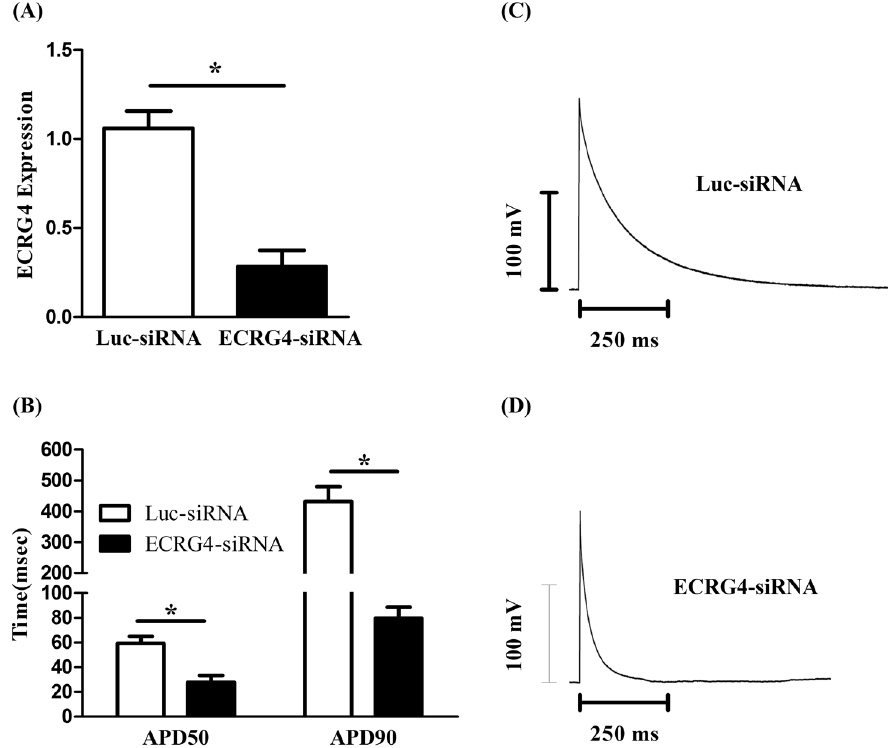
Figure 6. Knockdown ECRG4 in neonatal atrial myocytes shortens APD. Neonatal atrial CMs were transduced with lentivirus expressing Ecrg4-siRNA or luciferase-siRNA for 36 hours and the knock down of ECRG4 was confirmed by real-time PCR showing a 74% decreased ECRG4 expression in Ecrg4-siRNA (black bar) relative to Luc-siRNA transduction (open bar) ( A , P < 0.05). Thirty-six hours after transduction, AP was recorded using patch-clamp on GFP positive CMs. Representative recordings showing APs in Luc-siRNA ( C ) and Ecrg4-siRNA ( D ) transduced CMs. Quantitative analysis of APD 50 ( B , left panel) and APD 90 ( B , right panel) showed 53% and 81% decrease, respectively, in Ecrg4-siRNA (black bars) relative to Luc-siRNA (open bar) transduced atrial myocytes (n = 8, P < 0.05 in both APD 50 and APD 90 ). Data were presented as “Mean ± SD”, and the knockdown experiment was performed in triplicate and repeated three times.